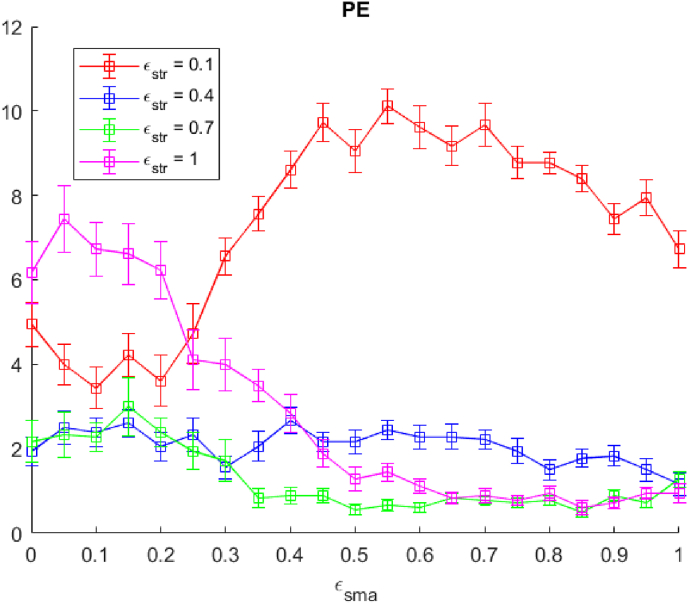
Perseverative Errors as a function of εsma, for four different values of εstr. Consistent with Fig. 15, perseverative errors are infrequent except when εsma is low or when εstr approaches 0. Error bars show one standard error from the mean.